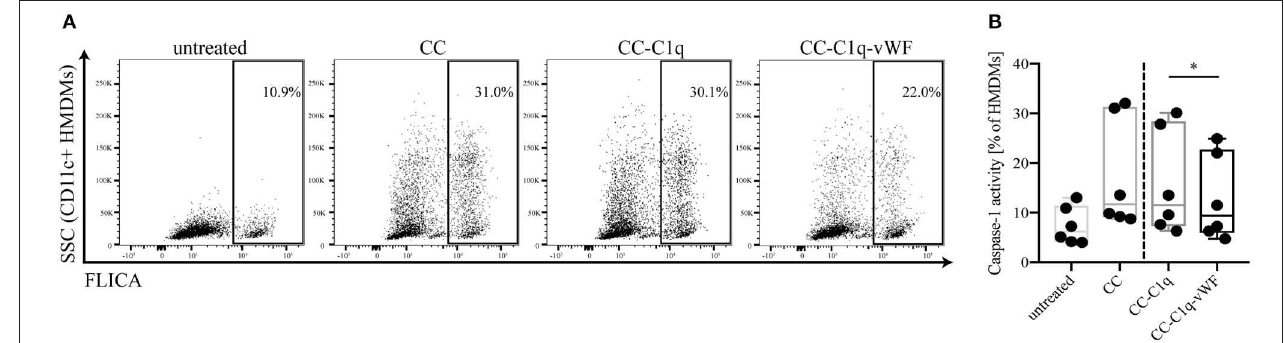
FIGURE 5 | CC-C1q-vWF complexes lead to a reduced caspase-1 activity in HMDMs. HMDMs were kept untreated or treated with CC, CC-C1q, or CC-C1q-vWF complexes for 18h and analyzed for caspase-1 activity by flow cytometry. Activity of caspase-1 was determined by the percentage of CD11c + cells in the FLICA + gate. (A) Flow cytometry dot plots show one out of six independent experiments. (B) Quantification of caspase-1 activity for pooled data is shown. Horizontal lines in the box plots denote median while the boxes indicate interquartile range and whiskers minimum and maximum values. Data points represent